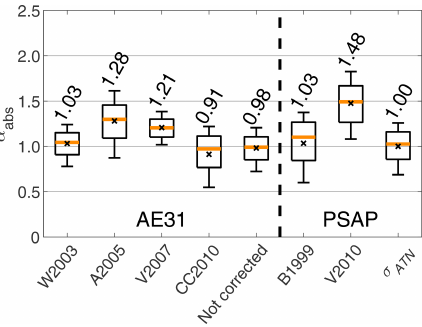
Figure 6. The absorption Ångström exponent ( α abs ) for all the dif- ferent AE31 and PSAP correction algorithms. The orange line in the middle of the box is the median; the black circle is the mean; the edges of the boxes represent the 25th and 75th percentiles, and the whiskers represent the 10th and 90th percentiles of the data. The values given above each box show the corresponding median